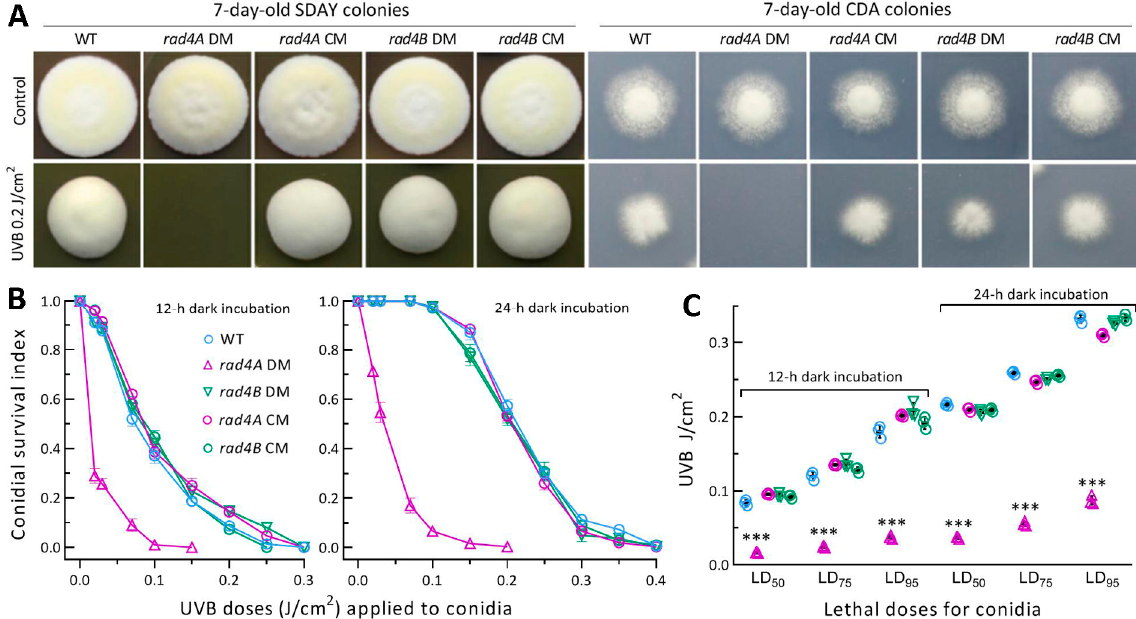
Figure 3. Essentiality of Rad4A versus dispensability of Rad4B for B. bassiana ’s resistance to UVB irradiation. ( A ) Images for 7-day-old colonies of disruption mutants (DMs) and control (CM and WT) strains grown in the optimal regime after SDAY and CDA plates inoculated with ~10 3 conidia were irradiated at the UVB dose of 0.2 J/cm 2 . ( B ) Survival trends of conidia incubated for 12 and 24 h in the dark after exposure to gradient UVB doses. ( C ) LD 50 , LD 75 and LD 95 estimated as indices of conidial UVB resistance from fitted survival trends. *** p < 0.0001 in Tukey’s HSD test. Error bars: SDs from three independent replicates.